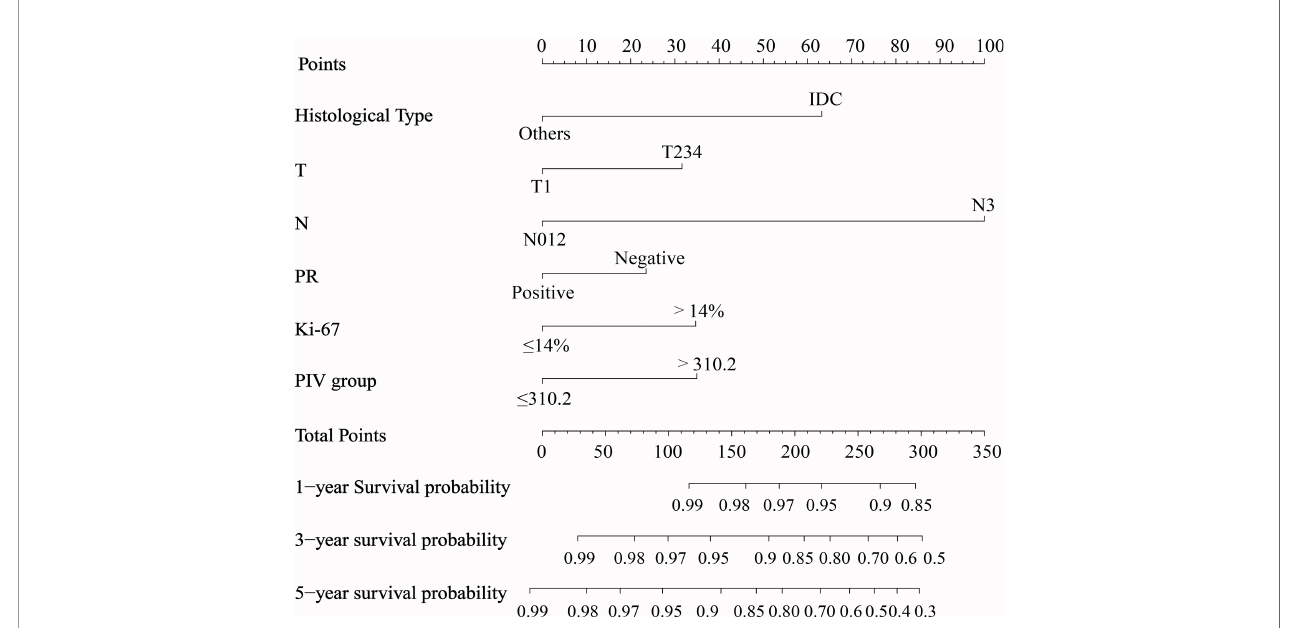
FIGURE 2 | Nomogram to predict 1-, 3-, and 5-year overall survival generated using the whole cohort. IDC, invasive ductal carcinoma.